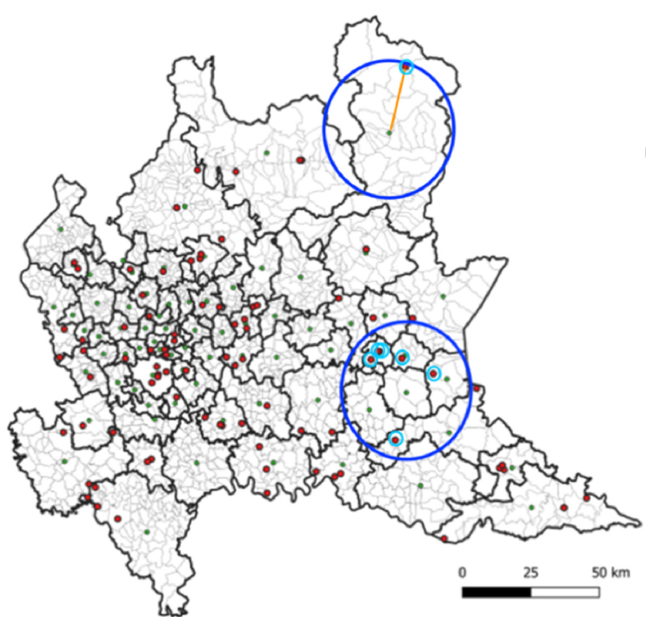
Figure 2. Map of the Lombardy region, indicating the boundaries of the 77 generated districts (see text for details) and their centroid (green dots), together with the position of the air pollutants recording stations (red dots). For each district, the computation of the air pollutants time-series was based on the recorded values of the closest recording stations (maximum 5) in a radius of 25 km around the centroid, with values weighted according to their radial distance to the centroid (see text for